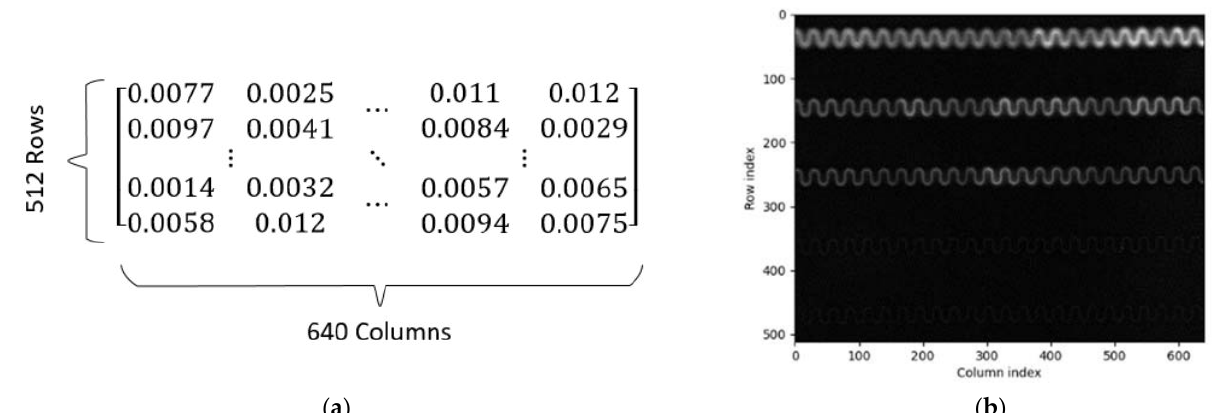
Figure 11. Demonstration of input data matrix for ADR and its visualization: ( a ) Input data matrix example, precision set to 2 significant decimals; ( b ) The corresponding visualization of ( a ) in grayscale.